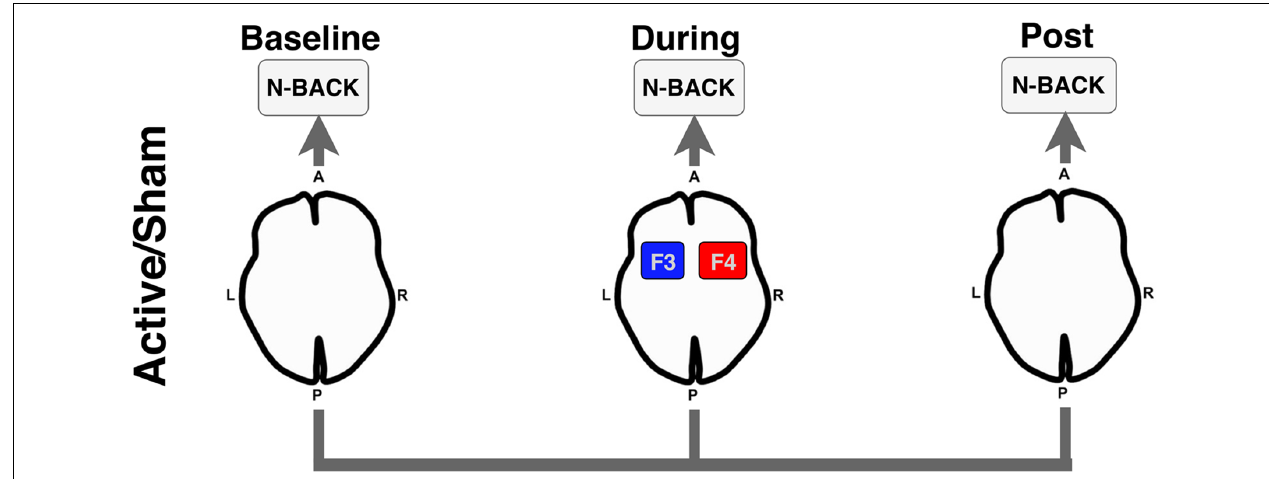
FIGURE 1 | Experimental design for the functional magnetic resonance imaging (fMRI) N-Back task. Participants underwent an N-Back task before (Baseline), during active or sham stimulation (During), and after stimulation was stopped (Post). Anode = red; Cathode = blue. A, anterior; P, posterior; L, left; R,